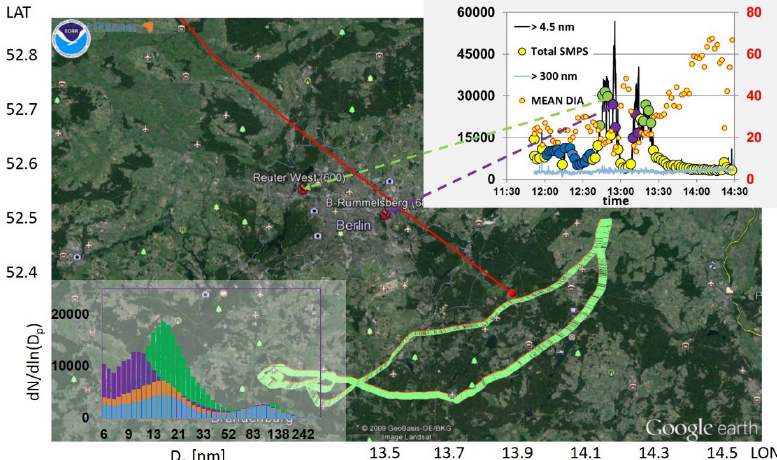
Figure 2. Particle number concentration (particle diameter D p > 20nm) on 12 June 2014 during the ultralight aircraft measurements (W. Junkermann, KIT, Garmisch-Partenkirchen). Green indicates flight track, white is Berlin city limits, the red line is HYSPLIT back trajectory for the second mamixum (plume), which derived from the power plant in Rummelsburg, and white dotted lines indicate city plume range. Maxima, exclusively in the ultrafine mode, were found in the pollution plumes of the two power plants in Rummelsburg and Reutter- West. The inserts show timeline of particle number concentrations (cm − 3 ) from CPC (black line), SMPS, large dots, fine particles > 300nm (grey) (cm − 3 ]) and geometric mean diameter (nm), (small dots) and size distributions within city and power plant plumes.